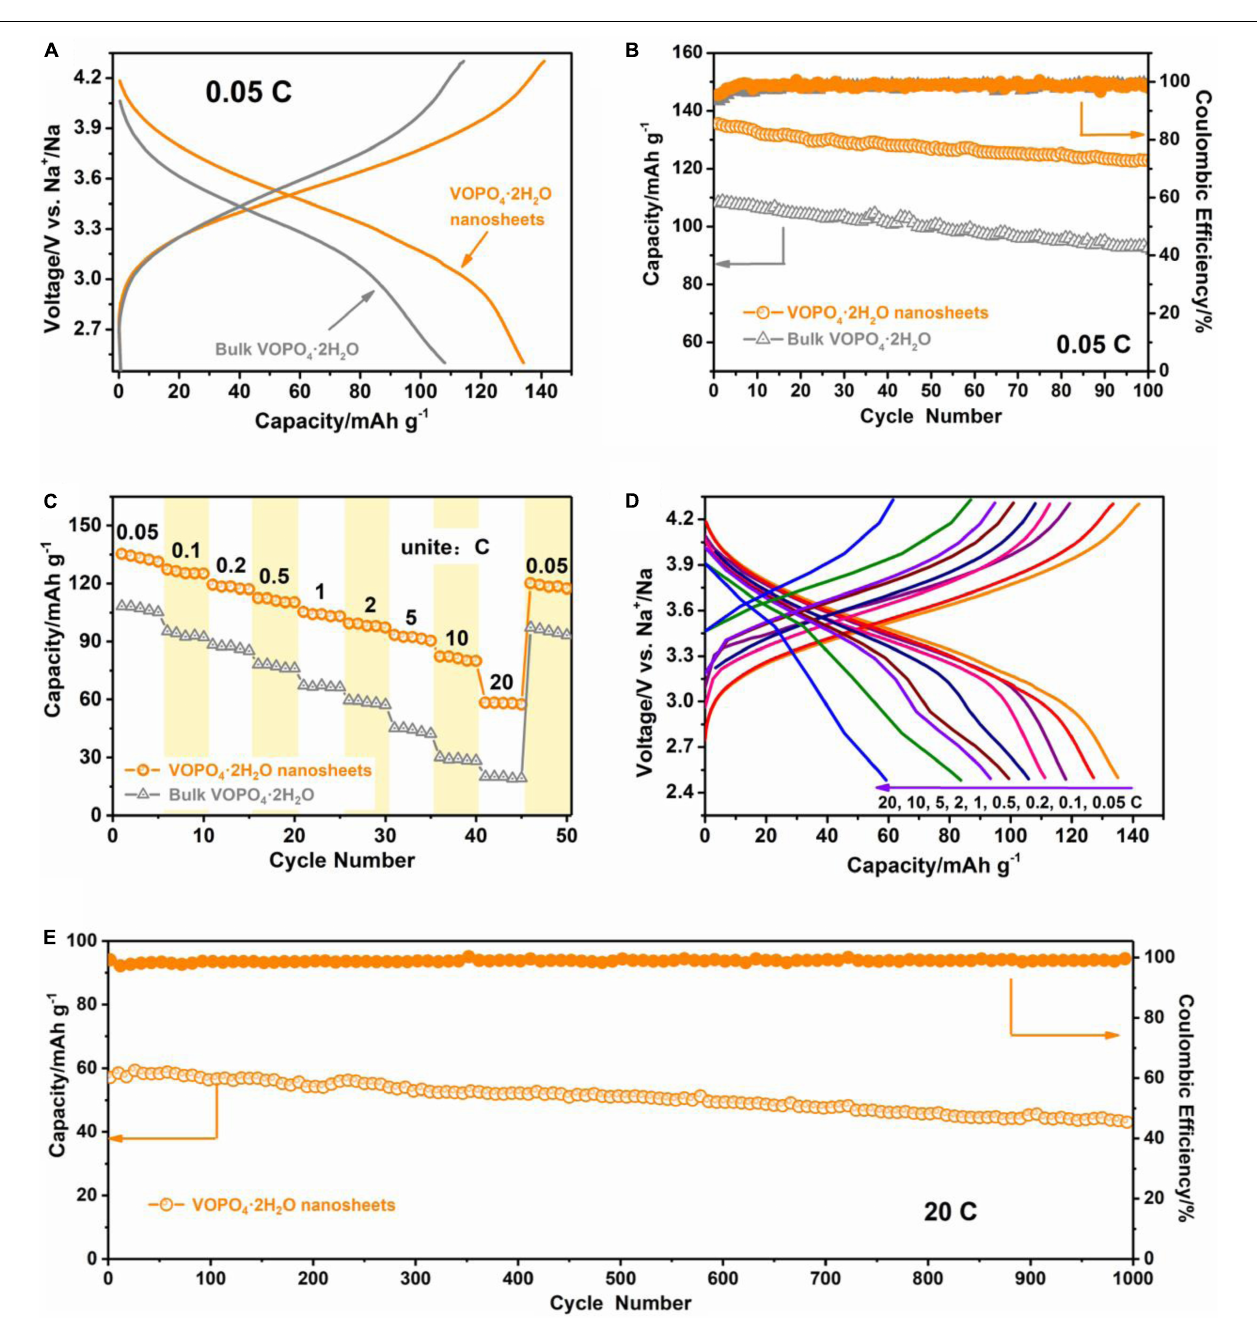
FIGURE 3 | Sodium storage performance of the VOPO 4 · 2H 2 O nanosheets and bulk VOPO 4 · 2H 2 O. (A) the galvanostatic charge/discharge profiles at 0.05 ◦ C; (B) cycling performance at 0.05 ◦ C; (C) rate capabilities; (D) galvanostatic charge/discharge curves of VOPO 4 · 2H 2 O nanosheets at various rates; and (E) long-term cycling behavior of VOPO 4 · 2H 2 O nanosheets at 20 ◦ C (the cell was initially activated for five cycles at 0.05 ◦ C).